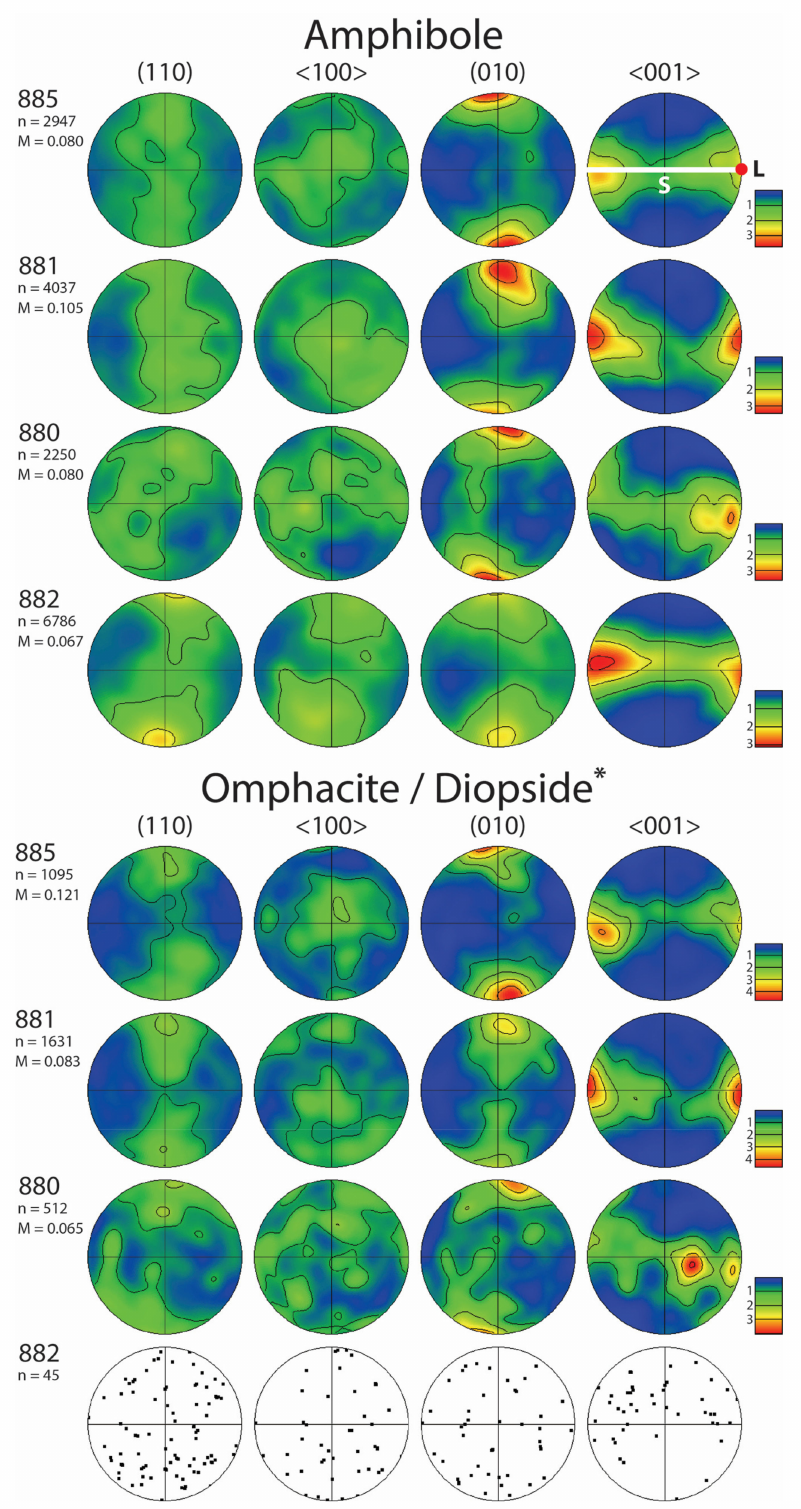
Figure 5. Amphibole and omphacite pole figures (PFs). PFs are presented in the lower hemisphere using an equal area projection. S indicates foliation, and L indicates lineation. Fabric strength of the mineral is shown as the M-index (M). A half scatter width of 20 ◦ was used. The color coding (different for each sample) refers to the density of data points, and contours are shown in multiples of uniform distribution. n: number of grains. * Diopside for sample